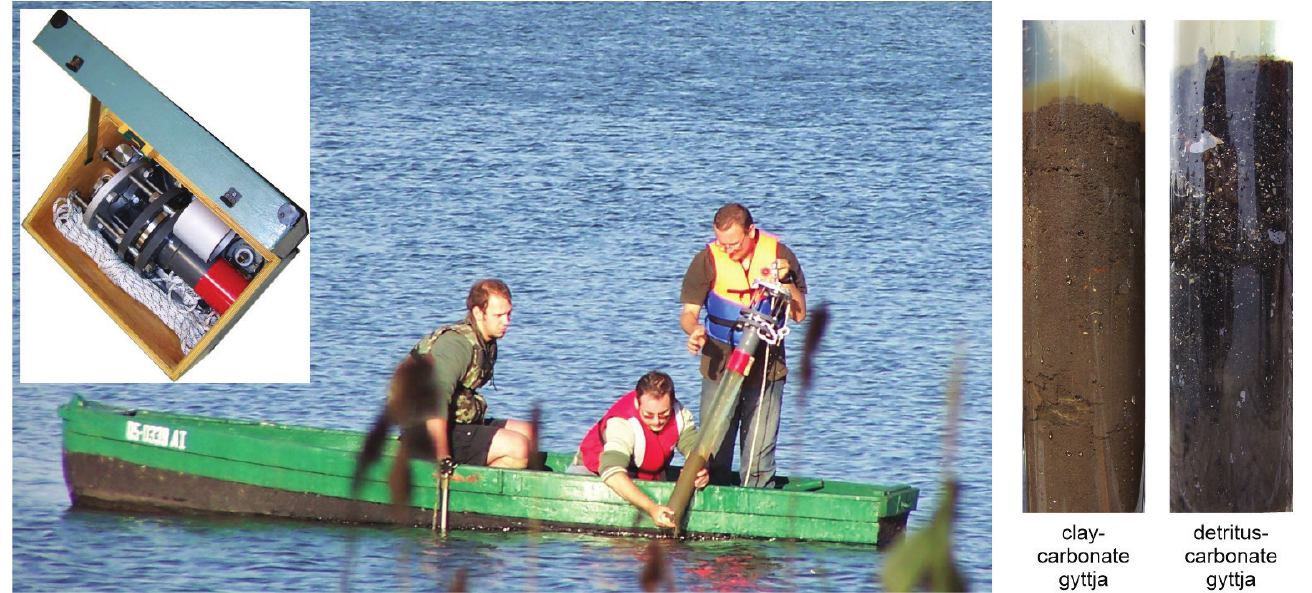
Figure 4. Collection of Gopło bottom sediments by sampler, and sample sediment cores.